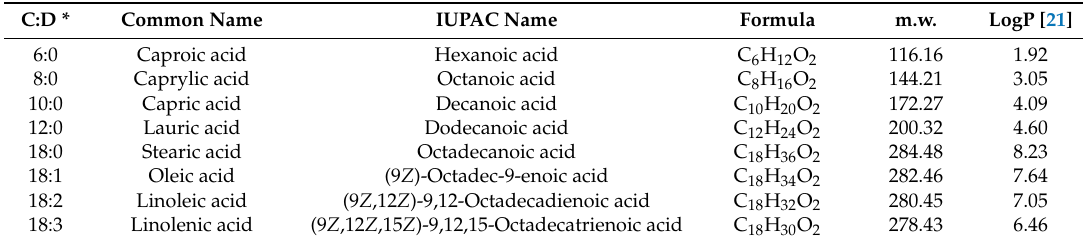
Table 1. Characteristics of the selected fatty